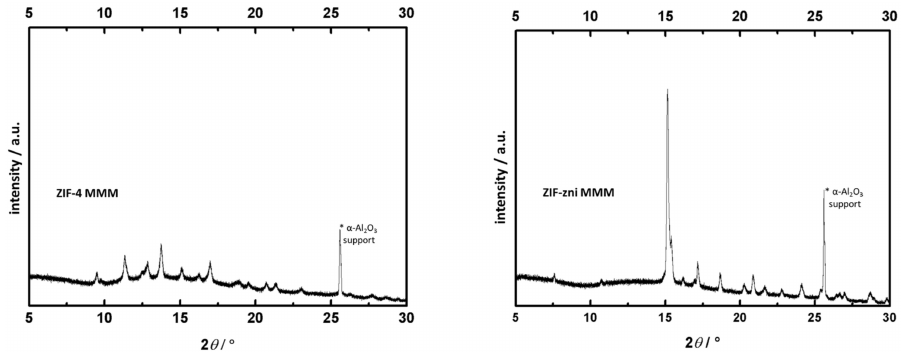
Figure 6. X-ray diffraction patterns of the two different filler based MMMs. ( left ) ZIF-4 particles and ( right ) ZIF-zni particles both embedded in Matrimid.